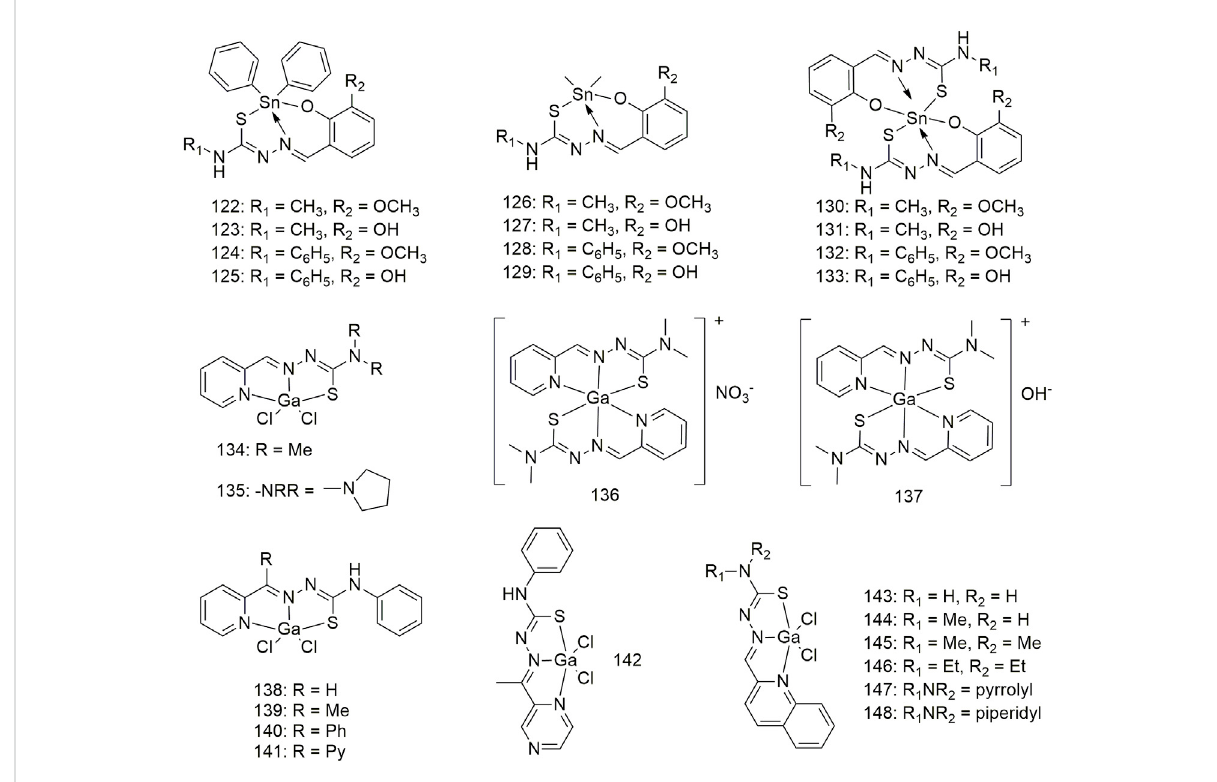
2:1 and 1:1 exhibit signi fi cant anti-proliferative activity against the NCI-H460 cell line, and their IC 50 values are between 0.72 and 0.43 μ M. The anti-proliferative activity of Ga (III) complexes with a metal/ligand ratio of 1:1 (complex 135 ) was signi fi cantly higher than that of the 1:2 (complex 137 ) (Qi et al., 2017). Complexes 135 and 137 signi fi cantly promote